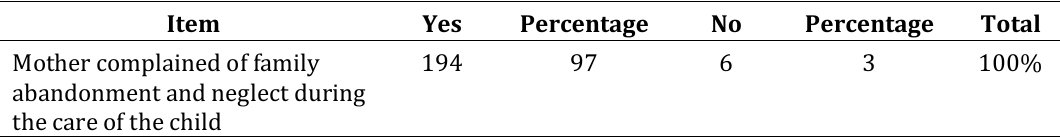
Components of Psychosocial Care Social Care Emotional Care Physical Care Spiritual Care Mental Care Financial Care Cultural Care Communication Care Educational Care